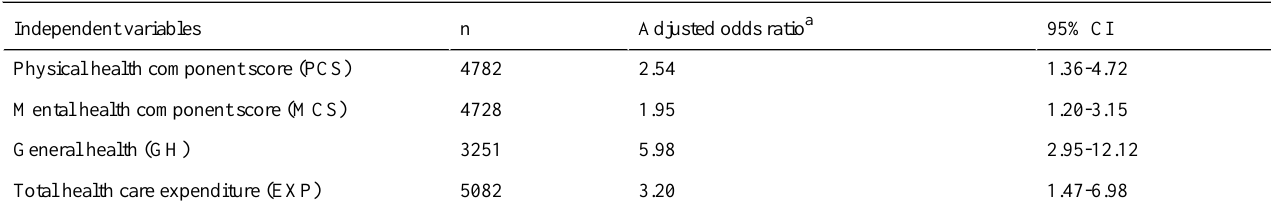
Table 4. Prediction of patient